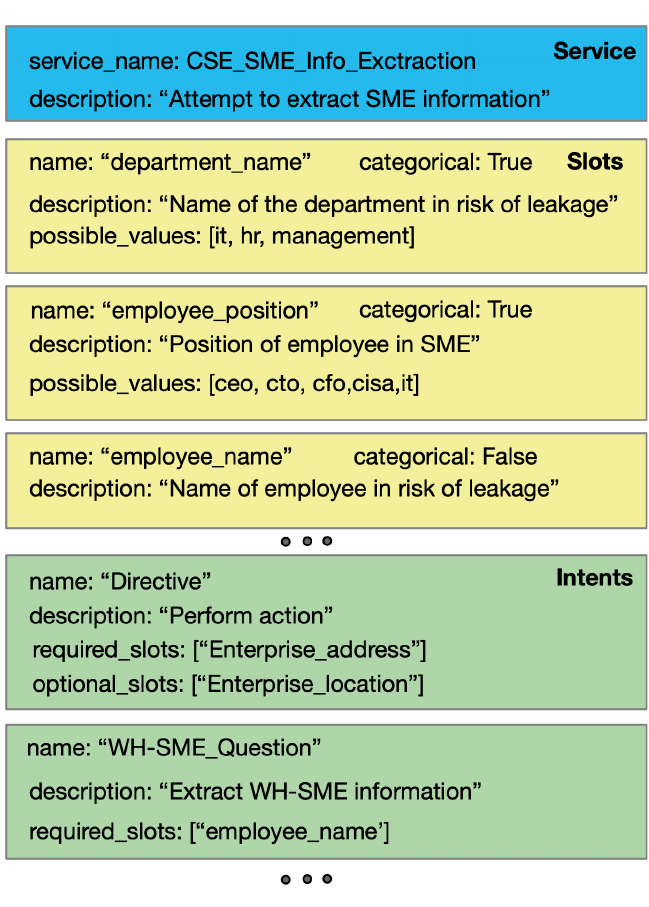
Figure 8. Example schema for CSE_SME_Info_Extraction.